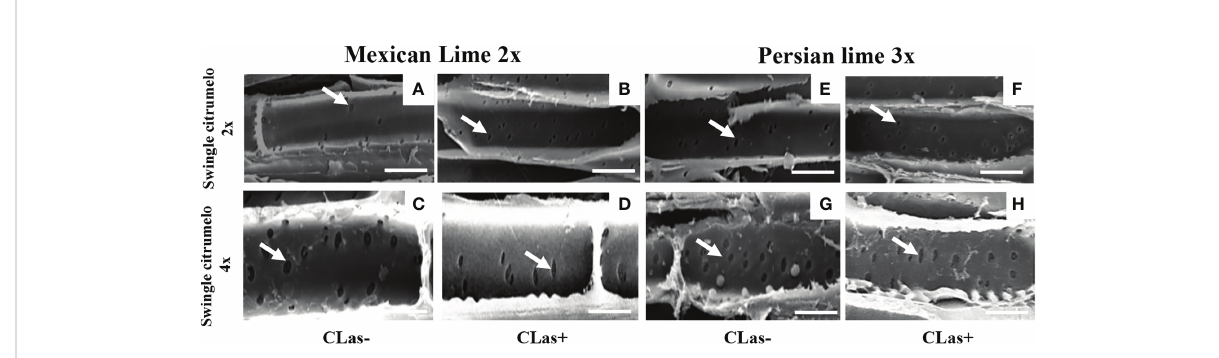
FIGURE 3 Longitudinal SEM of 2x (A, B, E, F) and 4x (C, D, G, H) root phloem cells of Swingle citrumelo rootstocks grafted with 2x or 3x limes infected (CLas+) or not (CLas-). White arrows indicate the pores in the phloem cell wall. Bars = 15 µm.